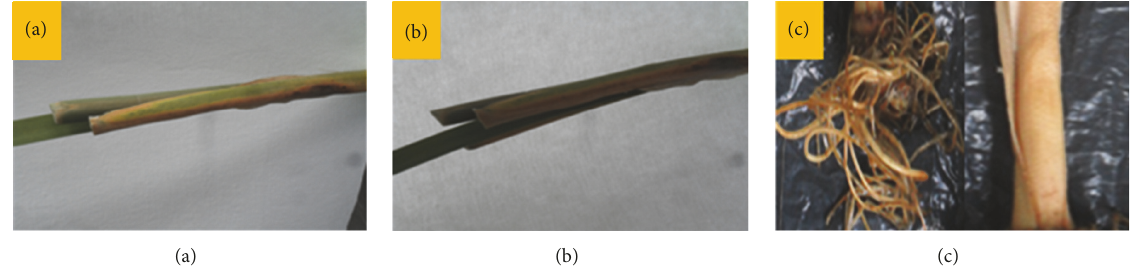
Figure 5: Typha latifolia phytotoxicity in treatments: (a) 50%, (b) 75%, and (c) 100% [52].